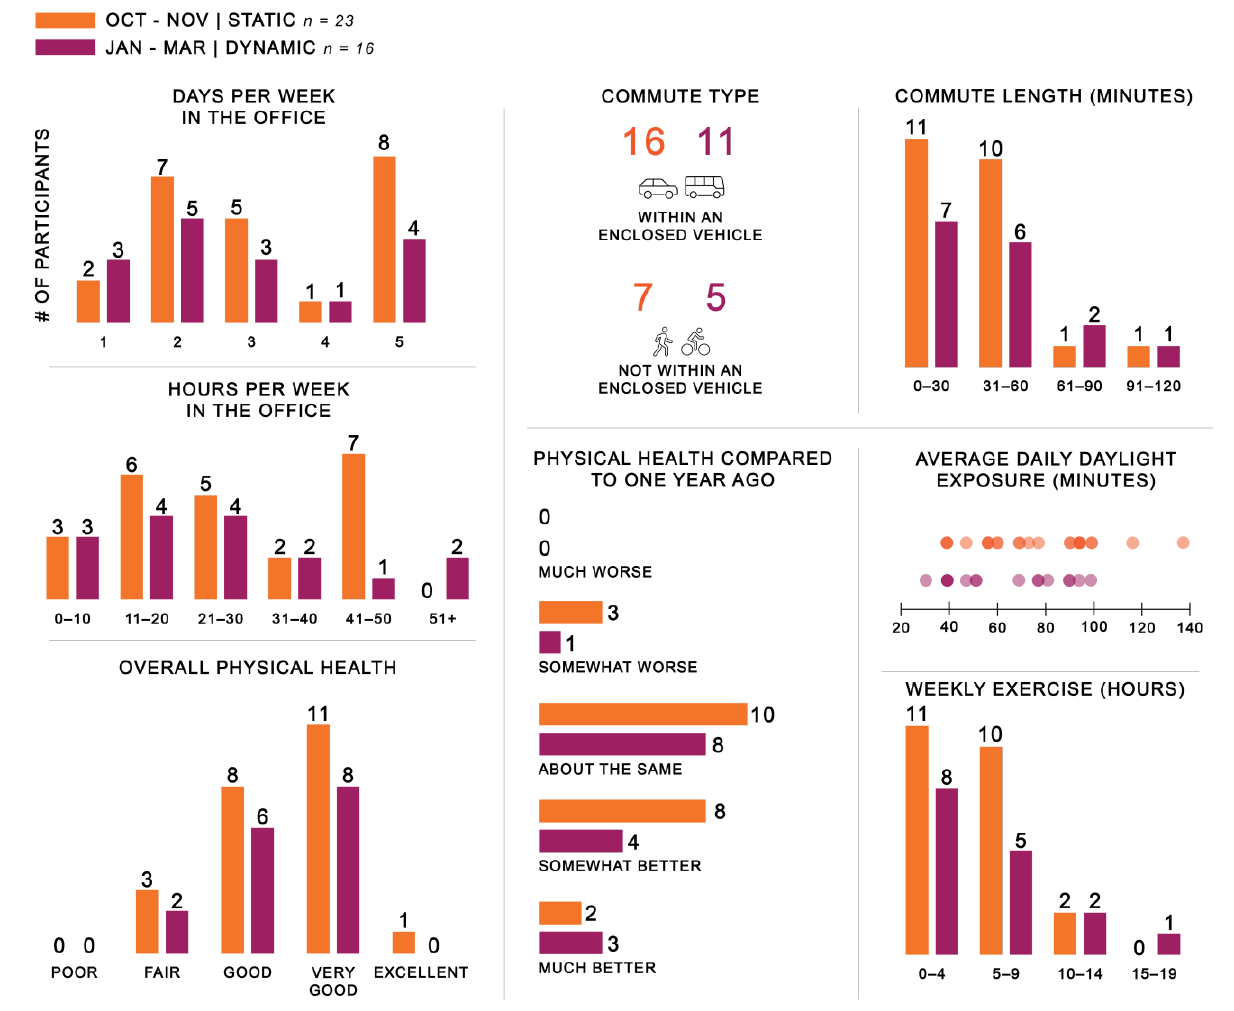
Figure 6. Participant lifestyle factors